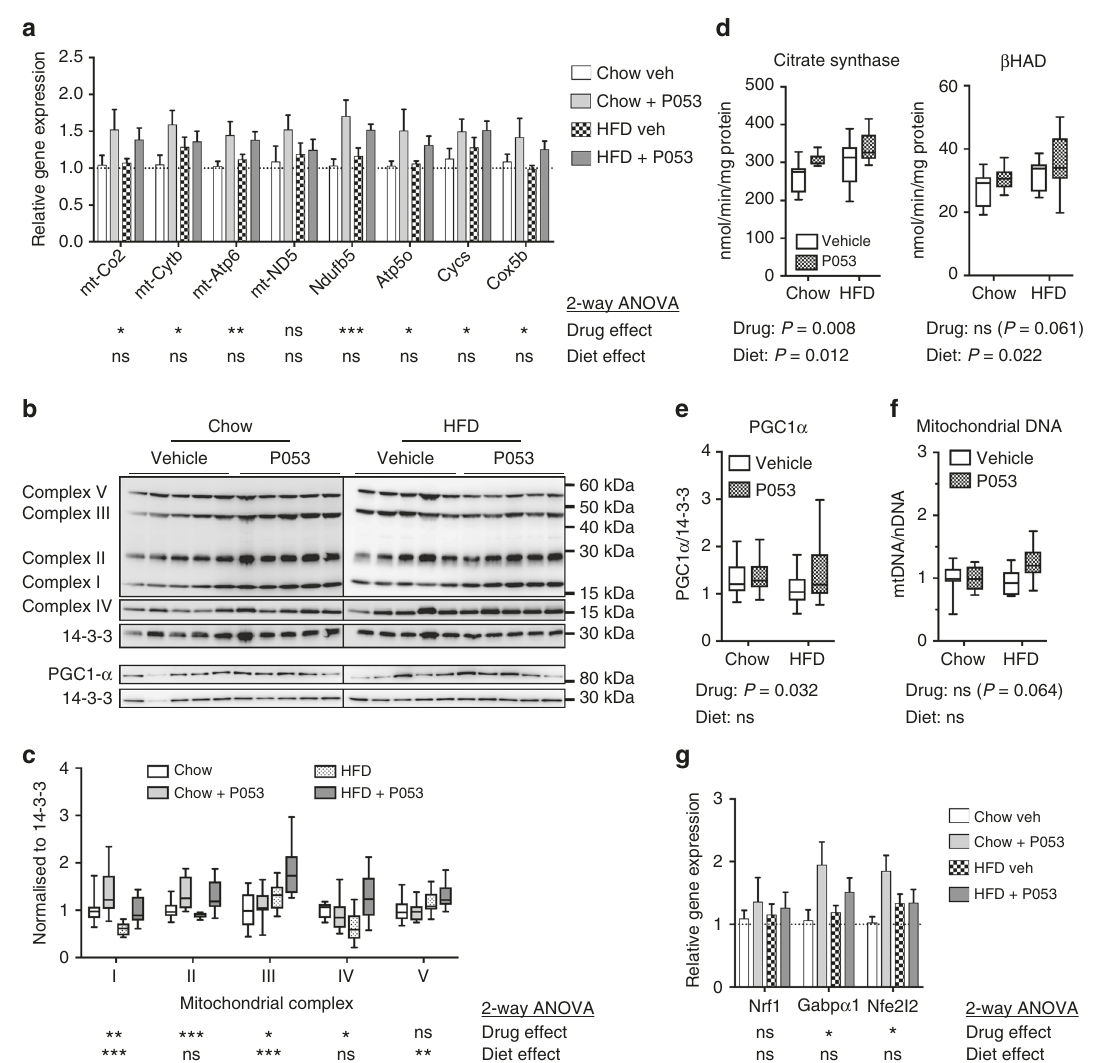
Fig. 6 CerS1 inhibition increases mitochondrial markers in SkM. a Levels of mitochondrially (mt)- and nuclear-encoded respiratory complex subunits in SkM, as determined by real-time PCR; n = 9 for chow diet groups; n = 10 for HFD groups. b Western blots of respiratory complex subunits in SkM. c Densitometry for respiratory complex subunits relative to 14-3-3 protein. d Citrate synthase and β -hydroxyacyl coenzyme A dehydrogenase ( β HAD) activity in SkM. b – d , n = 10 mice for all groups except the chow + P053 group, for which n = 8. e Western blot of PGC-1 α protein levels with densitometry normalised to 14-3-3 protein, n = 18 – 20 mice per group. f Mitochondrial DNA (mtDNA) content, normalised to nuclear DNA (nDNA) and expressed relative to the mean of the control group; n = 10 mice for all groups except the chow + P053 group, for which n = 8. g Gene expression levels for regulators of mitochondrial biogenesis and function, as determined by real-time PCR; n = 8 for chow diet groups; n = 10 for HFD groups. a , g show mean ± SEM. Box and whisker plots show full data range with 25th – 75th percentile boxed, and horizontal bar marking the median. Statistical signi fi cance was determined by two-way ANOVA, with the main effect of the drug or diet shown beneath each result; * P < 0.05; ** P < 0.01; *** P < 0.001. Raw data for panels a and g